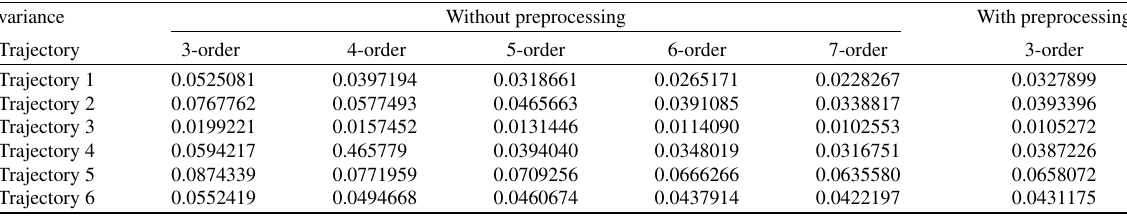
Comparison of the variances based on curve fitting with and without reprocessing variance